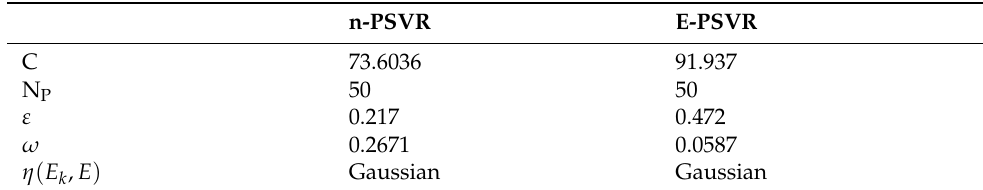
Figure 3. Convergence and sensitivity of the PSVR models. ( a ) Convergence of n-PSVR with various numbers of particles. ( b ) Sensitivity of n-PSVR to the penalty factor. ( c ) Sensitivity of n-PSVR to epsilon. ( d ) Convergence of E-PSVR with various numbers of particles. ( e ) Sensitivity of E-PSVR to the penalty factor. ( f ) Sensitivity of E-PSVR to epsilon. Table 1. Details of swarm particles with optimum